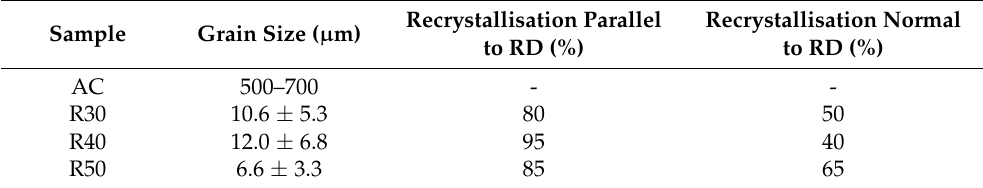
Table 3. Grain size and percentage recrystallisation of Mg-1 wt. % Zn as a function of the reduction per